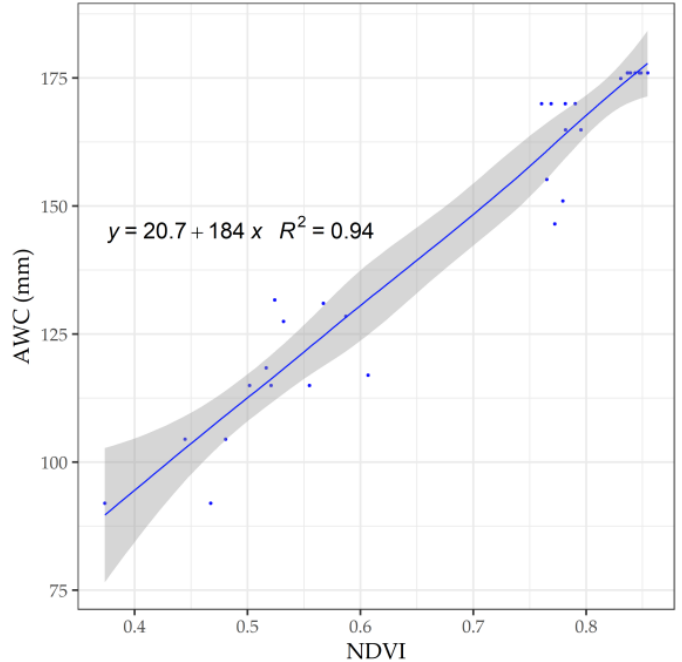
Figure 7. Diagram of the relationship between NDVI and AWC values.